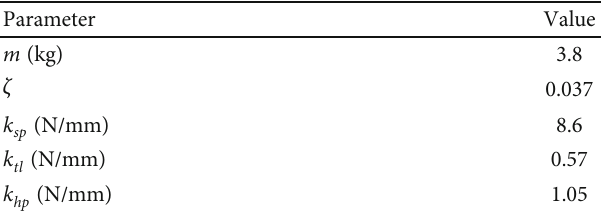
Table 1: Basic characteristic values for